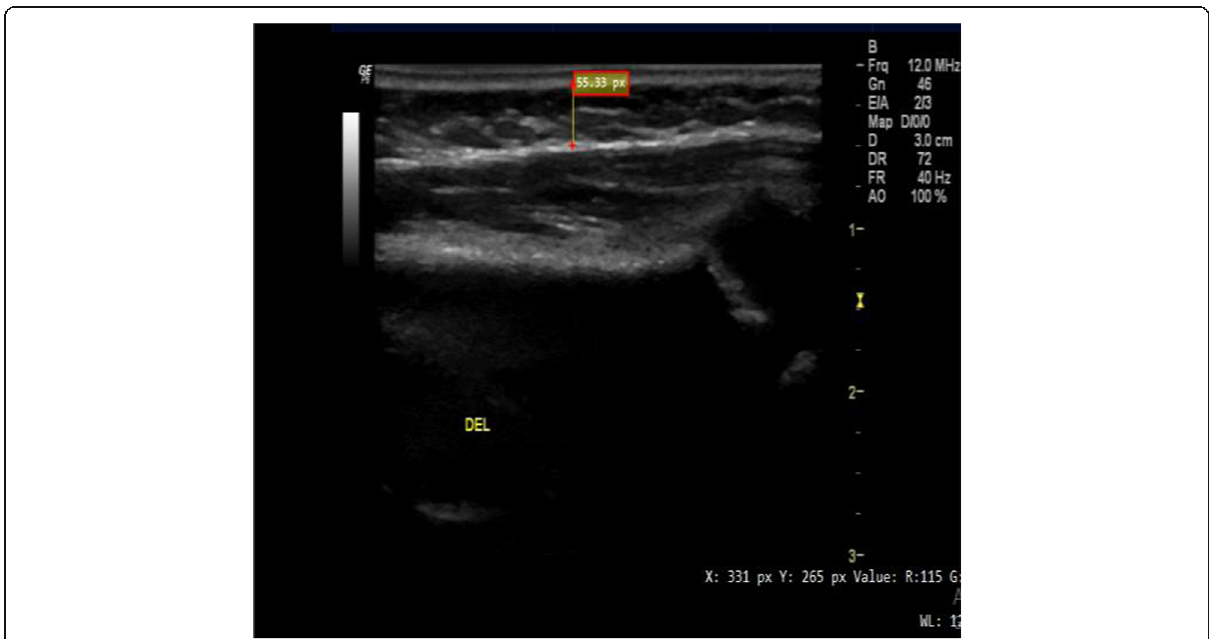
Fig. 2 Measurement of muscle thickness of the anterior deltoid muscle by ultrasonography